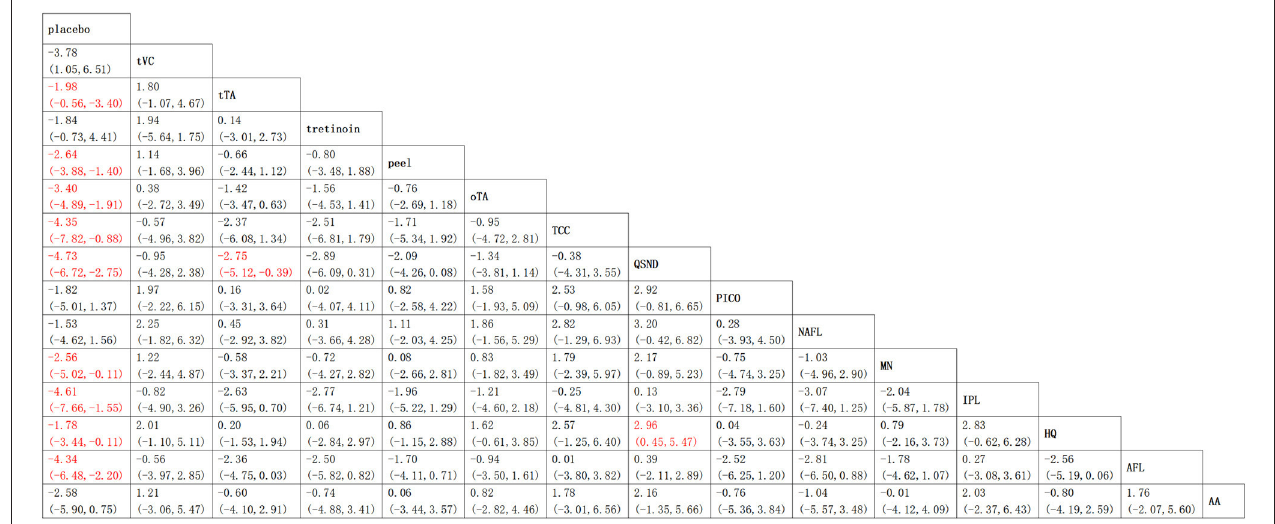
FIGURE 6 | Relative effects table. Comparison of the included interventions: mean difference (95% credible intervals). Each cell gives the effect of the column-defining intervention relative to the row-defining